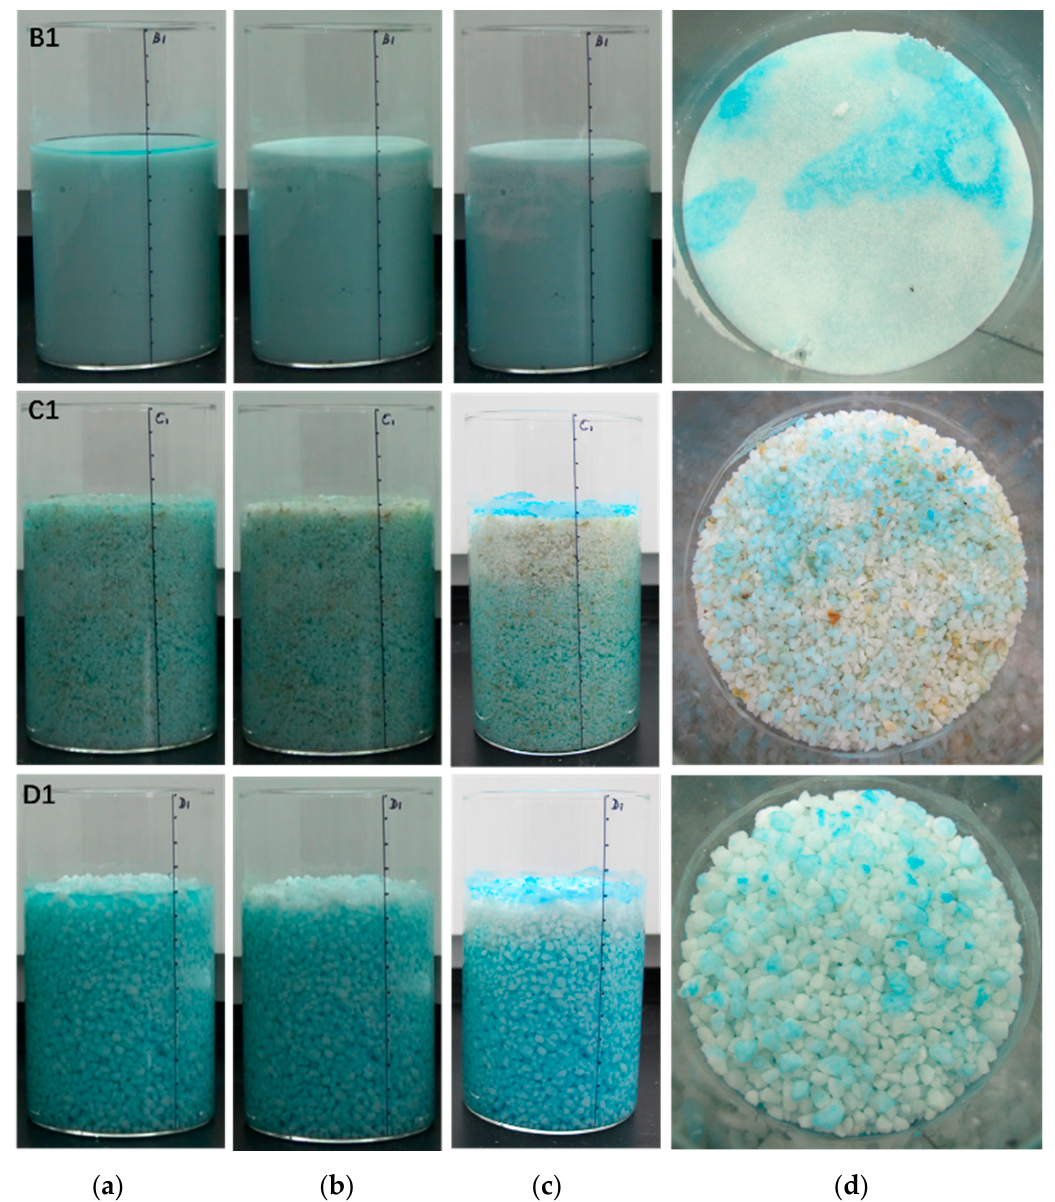
Figure 2. Process of change of salt solution in different samples. ( a ) Change of salt solution under the action of gravity and capillary force, placed for 0 h; ( b ) placed for 10 h; ( c ) placed for 40 h; ( d ) state of surface crystallization.